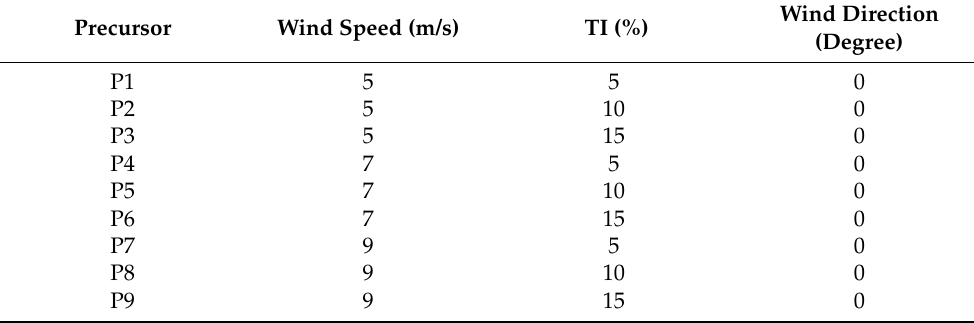
Table 1. Parameters of wind